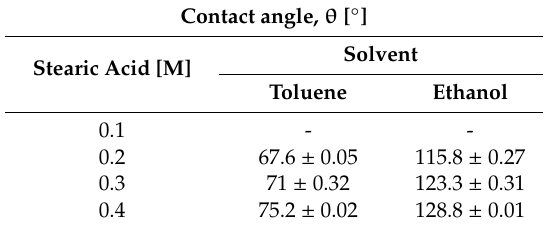
Figure 12. ( a ) Plot of contact angle vs. stearic acid concentration. Picture of a drop of water on flax fabric treated with 0.4 M stearic acid in toluene ( b ) or ethanol ( c ). fabric treated with 0.4 M stearic acid in toluene ( b ) or ethanol ( c ). Table 2. Contact angles for flax fabrics treated with stearic acid in di ff erent solvents. Table 2. Contact angles for flax fabrics treated with stearic acid in different solvents. Contact angle, θ [ ◦